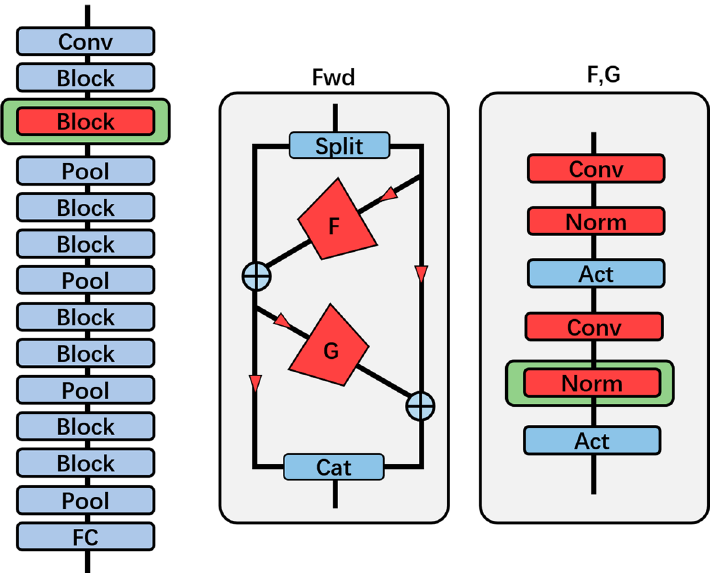
Fig. 3 Illustration of the Revnet architecture and its memory consumption. Modules contributing to the peak memory consumption are shown in red. The peak memory consumption happens during the backward pass through the first reversible block. At this step of the computations, all hidden activations within the reversible block are stored in memory